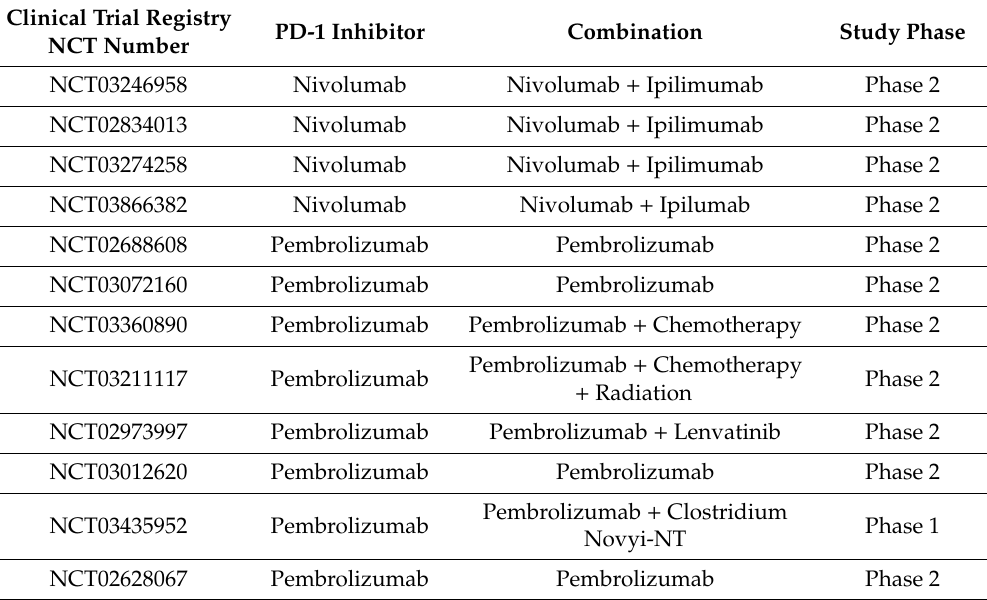
Table 1. Clinical Trials Evaluating the E ff ects of PD-1 Inhibitors in Thyroid Cancer.